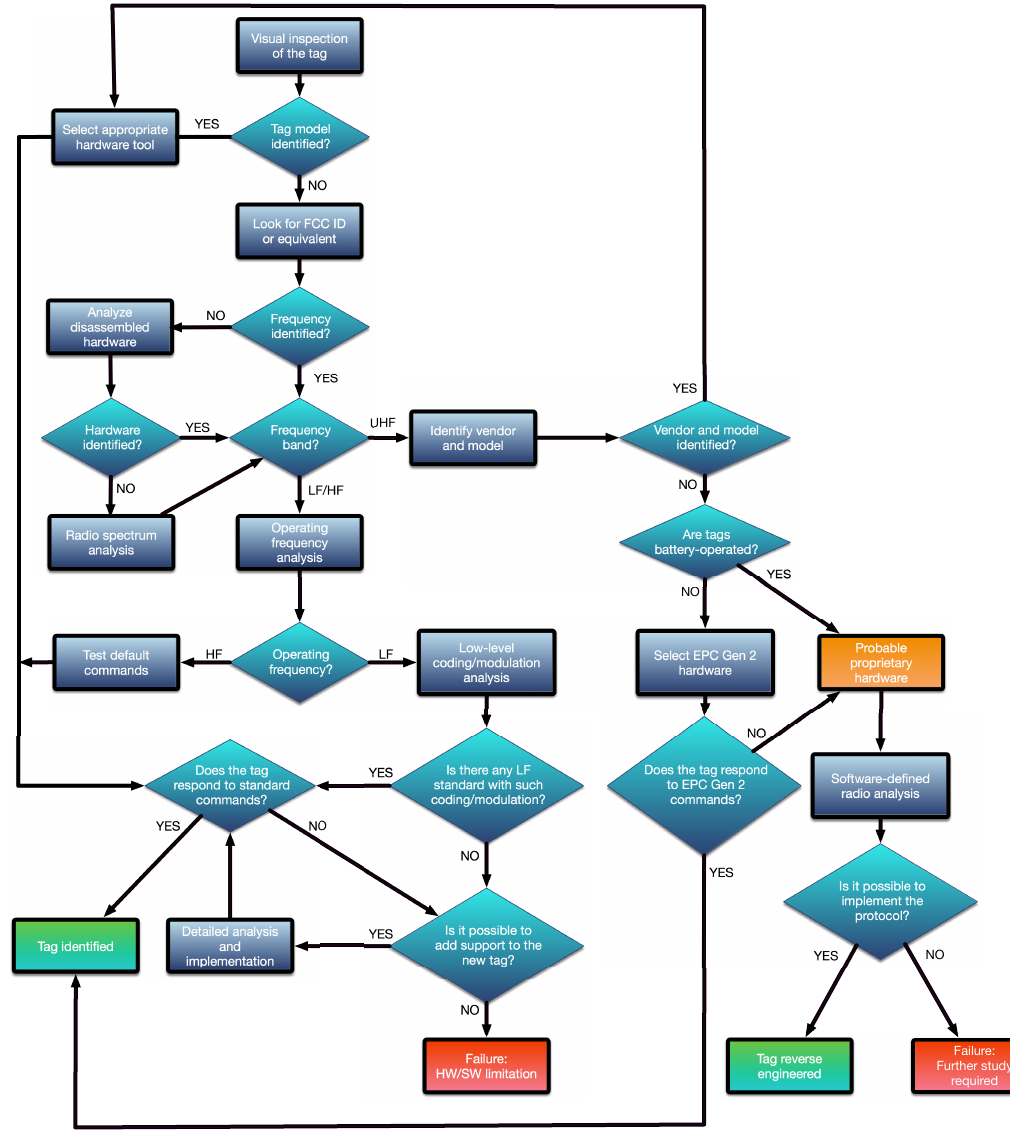
Figure 3. Flow diagram of the